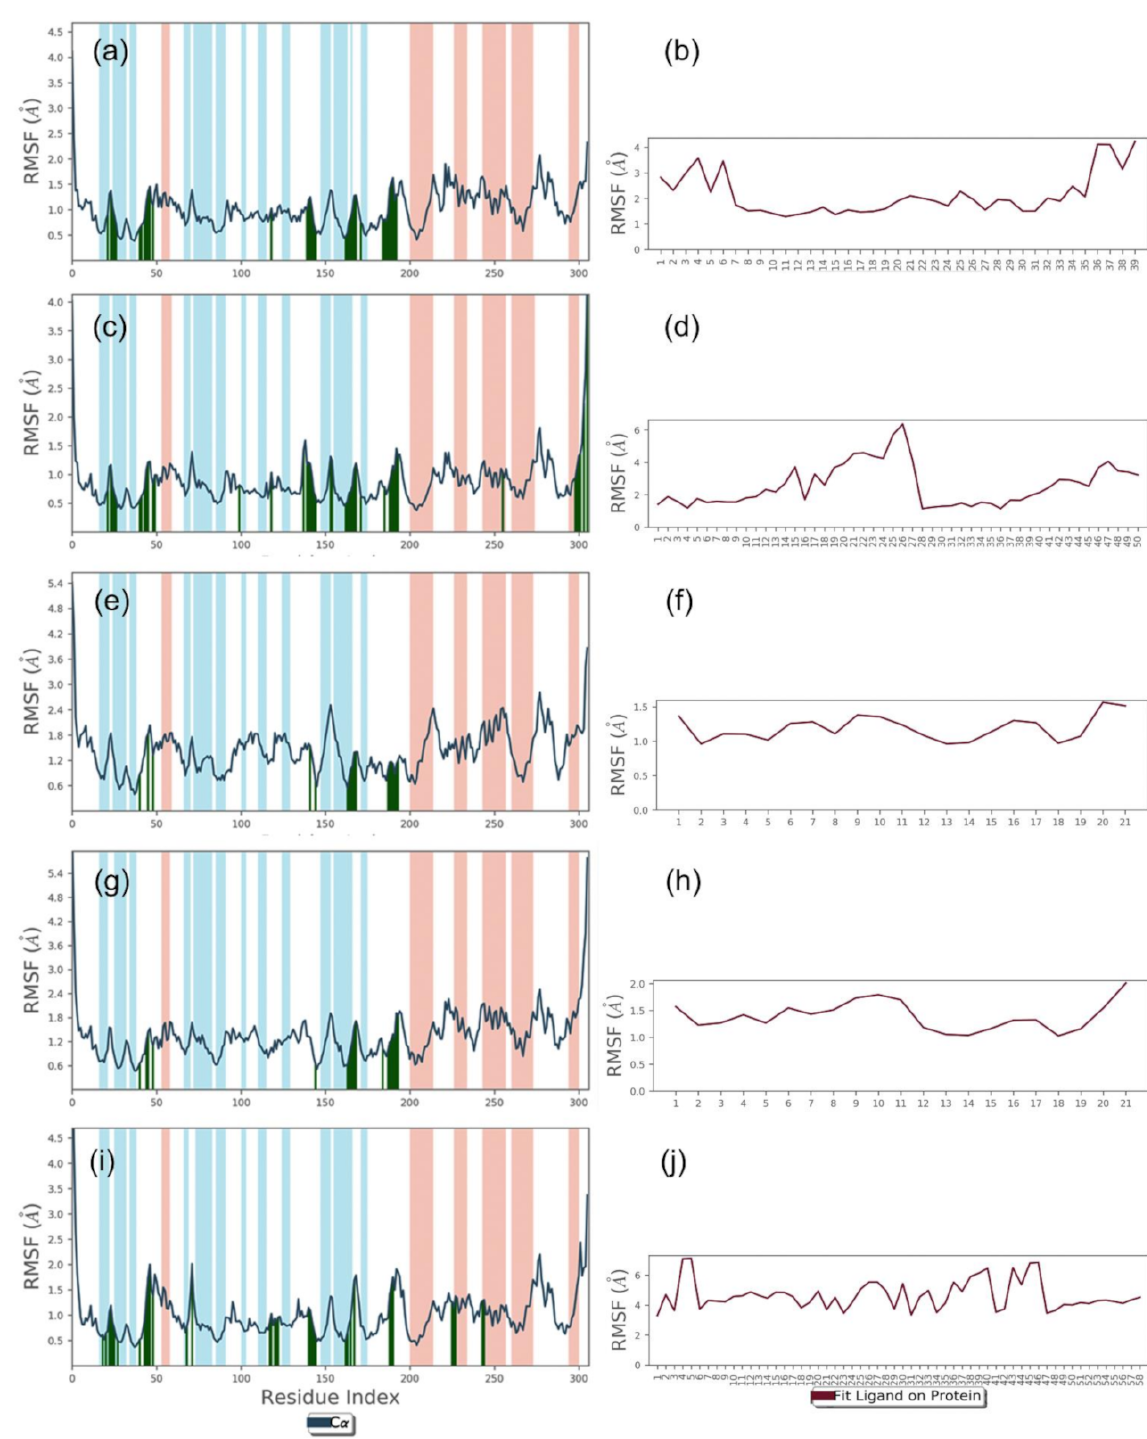
Figure 5. RMSF values plotted for alpha carbon atoms of viral protease and bioactive compounds fit on protein structure in the docked complexes of SARS-CoV-2 M pro with docked with natural products with selected compounds: ( a , b ) licuraside, ( c , d ) glucoliquiritin apioside, ( e , f ) 7,3 (cid:48) -Dihydroxy-5 (cid:48) -methoxyisoflavone, ( g , h ) licuroside, and ( i , j ) glycyrrhizin, obtained from the 100 ns MD simulation trajectory, extracted from the 100 ns MD simulation